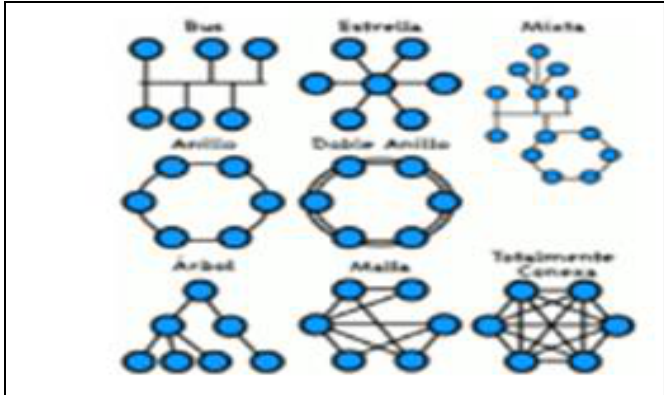
Figura 3: Diferentes topologías de Red. Fuente: Los autores,